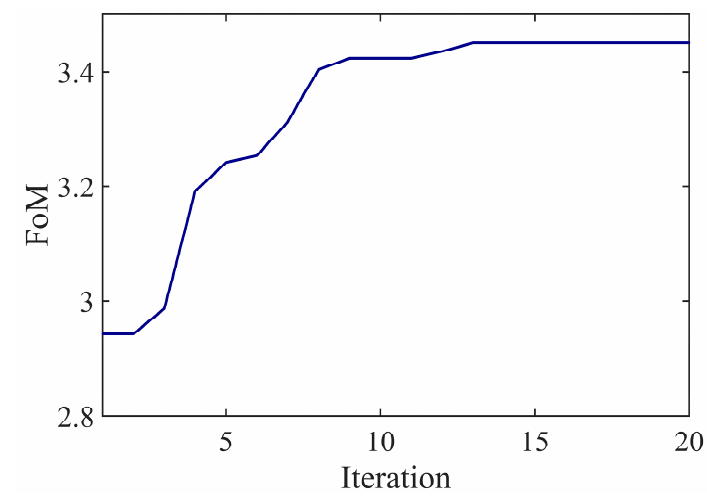
Figure 4. FoM curve of the device at each iteration.